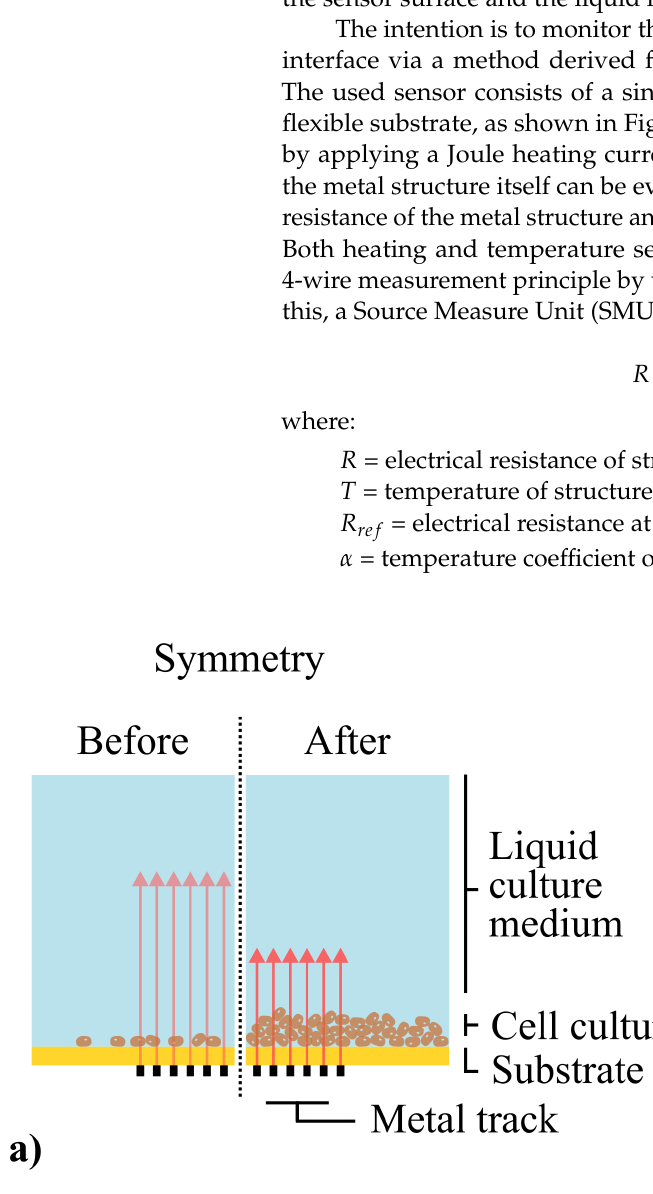
Figure 1. ( a ) Schematic cross-section of a planar resistive thermal sensor during measurements on a cell culture before and after proliferation. Heat transfer from the metal track to the liquid culture medium is illustrated by red arrows. We expect that a growing cell culture at the interface will impede the heat transfer. ( b ) As a result, when an identical Joule heating current pulse is applied, it is expected that the initial part of the temperature curve will become steeper as more cells accumulate at the interface. By monitoring the variation in the slope of this linear regression, we expect to be able to render cell proliferation in